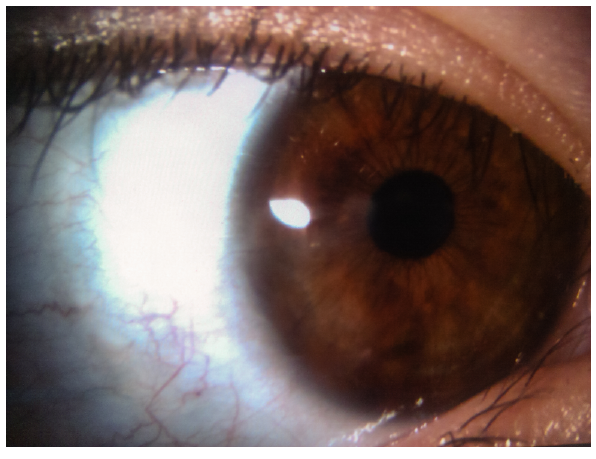
Figure 2: Slit-lamp photograph of the right eye, 11 months after therapeutic combination of infliximab and methotrexate. A nubecula of temporal peripheral and pericentral cornea is noticeable with infiltrates and neovascularization